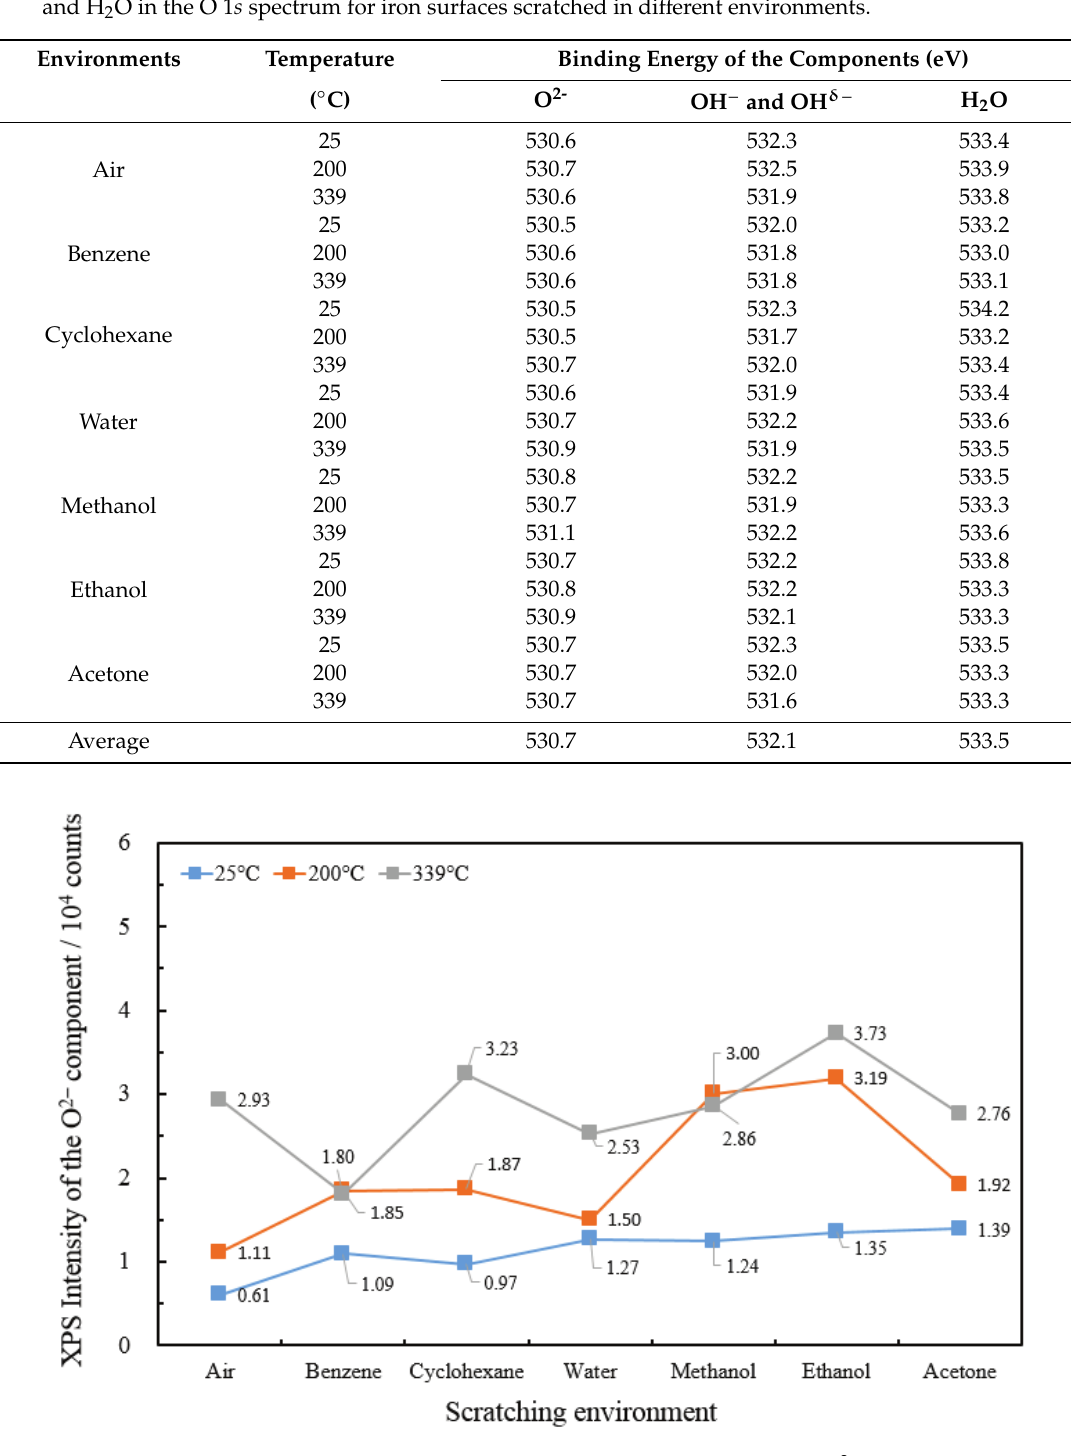
Figure 6. Dependence of the number of electrons counted, XPS intensity of the O 2 − component in the O 1 s spectra after the PE measurement at 25, 200, and 339 ° C for real iron surfaces on the scratching environments: (1) air, (2) benzene, (3) cyclohexane, (4) water, (5) methanol, (6) ethanol, and (7) acetone.